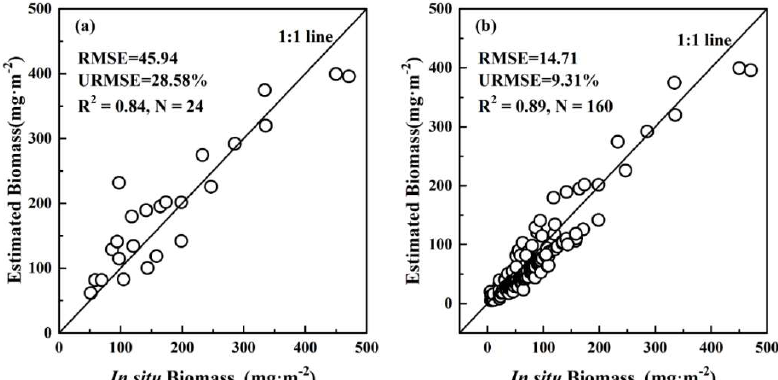
Figure 6. Validation results between in situ measured algal biomass and estimated algal biomass from MODIS observation. ( a ) results under algal bloom conditions; ( b ) results under all bloom and non-bloom